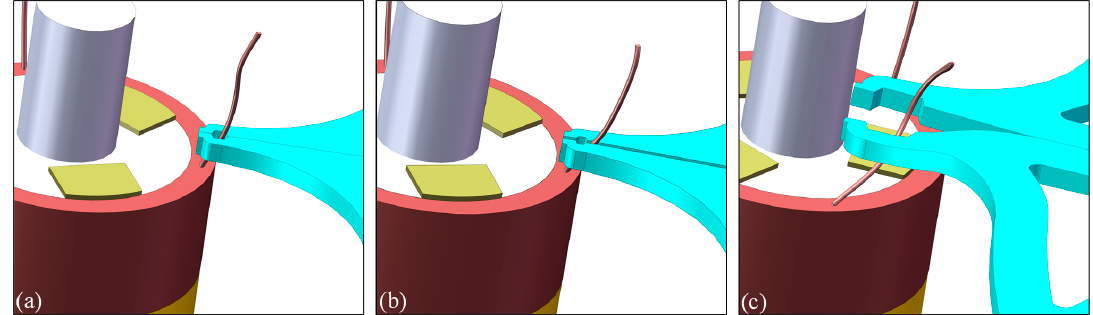
Figure 5. Analysis for the influence of dimension of the enveloped shape on clamping wires: ( a ) The wire is clamped accurately by the tip with proper size; ( b ) Incorrect clamping is due to the small size of the enveloped shape, and the wire is located on the outside of the enveloped shape; ( c ) Due to the large size of the enveloped shape, the tip collides with the shaft, which may damage the tip.